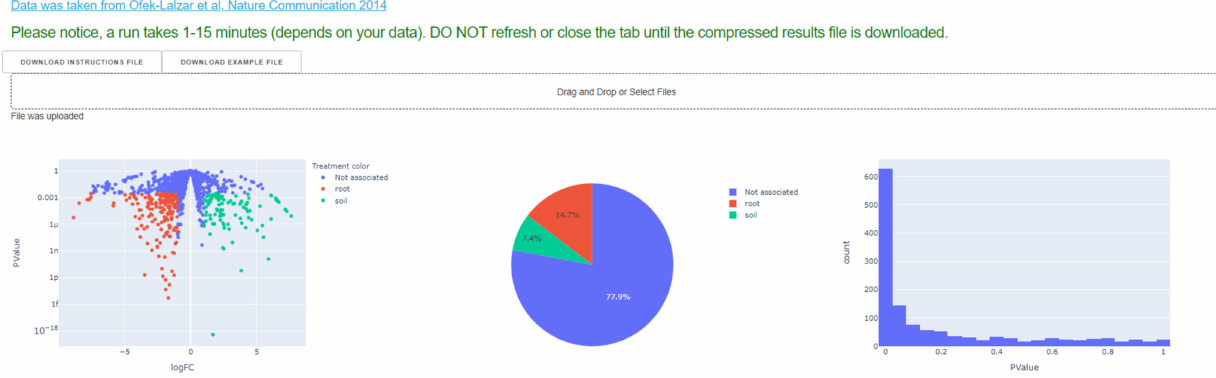
Figure 1. User interface of NetCom following the upload of the input file. Input files are uploaded via the ‘Drag and Drop or Select File’ bottom. An example input file is available (via the ‘Download example file’ grey bottom, top left). Once s valid file is introduced, the three plots on the bottom are